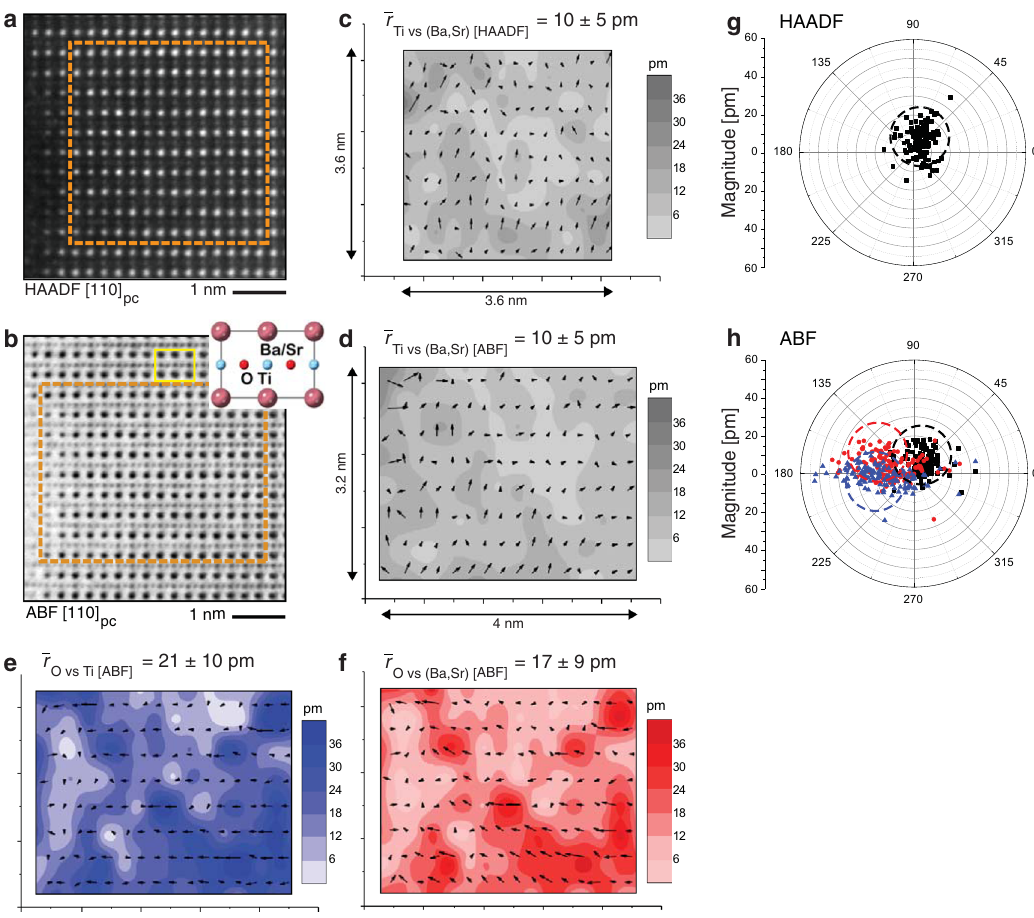
Fig. 2 Analysis of atomic displacements in BST6040. a HAADF image and b ABF image, viewed along the [1 1 0] pc zone axis of an ~15-nm-thick BST6040 grain. Dashed rectangles mark areas where displacements were determined. The inset in b shows the perovskite unit-cell viewed along [1 1 0] pc axis, one of which is marked by the yellow rectangle. c – f Displacements of Ti vs (Ba, Sr), O vs Ti and O vs (Ba, Sr) determined from HAADF ( c ) and ABF ( d – f ) images with respect to positions of these atoms in an ideal cubic phase with the corresponding average displacements ( (cid:1) r ). Arrows represent the direction and magnitude of the displacements and colours represent the magnitude of displacement given as contour plots (see the colour scale on the right of each image). g , h Compilation of the data presented in c – f in the form of polar plots, which delineate the orientation of atom displacements. Each symbol and its position in the polar plot correspond to one arrow, with black squares representing Ti vs (Ba, Sr), blue triangles O vs Ti and red circles O vs (Ba, Sr) displacements. The polar plots show that the symmetry of the local atomic structure is not cubic, is most likely polar and possibly possesses monoclinic or lower symmetry. Dashed circles mark areas where the majority of the individual type of displacements are